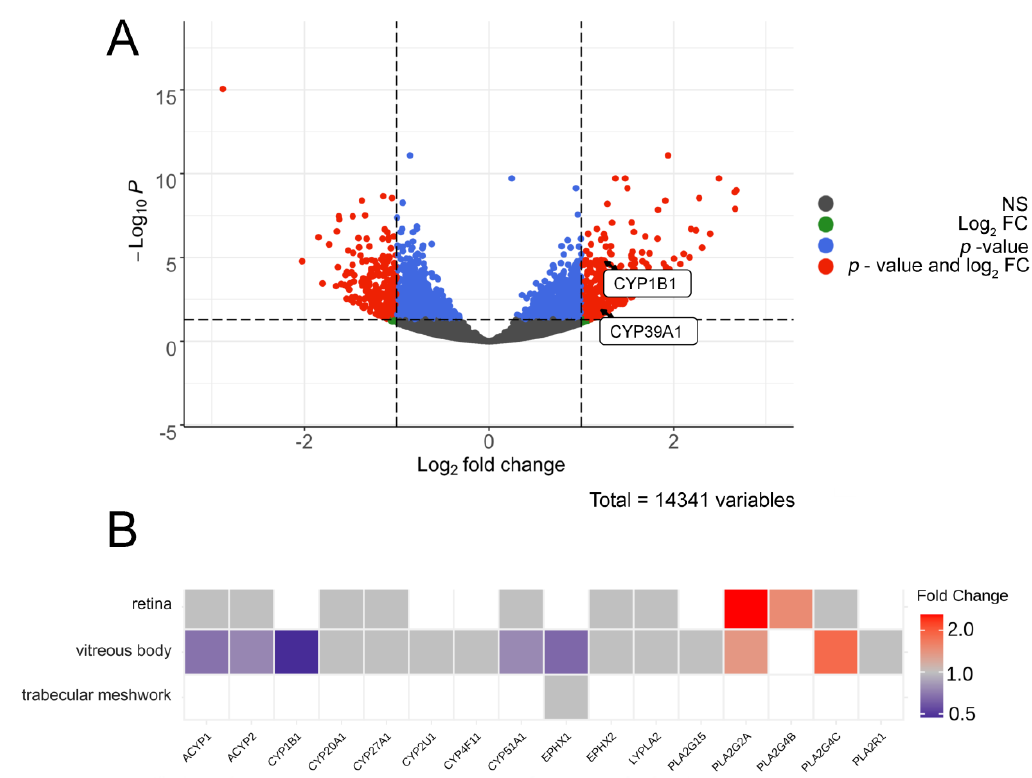
Figure 4. Bioinformatic analysis of enzymatic pathways responsible for production of the revealed POAG-specific lipid mediators in AH. ( A ) volcano plot indicating DEGs corresponding to signaling lipids-synthesizing enzymes in TM cells underwent long-term perfusion at high pressure according to analysis of the transcriptomic data 37. The X-axis indicates a log2 fold change in levels of transcripts in TM cells perfused at high pressure for 3 h as compared to 5 h. The Y-axis indicates -log10 p -values with the cut-off calculated according to Bonferroni correction. mRNAs that changed less than twofold (Log2 FC) or demonstrated non-significant (NS) alterations ( p > 0.05) are indicated in green and gray colors, respectively. The significantly changed transcripts ( p < 0.05) are denoted in red color (value and Log2 FC). ( B ) a clustered image map illustrating changes in expression of signaling lipids-synthesizing enzymes in the retina, vitreous body and trabecular meshwork of POAG patients determined from analysis of proteomic data. The map is built using the Euclidean distance and complete linkage clustering algorithm. Each entry is colored according to its fold change, rows represent tissues, and columns represent enzymes. Abbreviations: ACYP: acylphosphatase-2; CYP1B1: cytochrome P450 1B1, CYP20A1: cytochrome P450 20A1; CYP27A1: cytochrome P450 27A1; CYP2U1: cytochrome P450 2U1; CYP4F11: cytochrome P450 4F11; CYP51A1: cytochrome P450 51A1; EPHX1: epoxide hydrolase 1; EPHX2: epoxide hydrolase 2; LYPLA2: acyl-protein thioesterase 2; PLA2G15: phospholipase A2 G15; PLA2G4B: phospholipase A2 G4B; PLA2G4C: phospholipase A2 G4C; PLA2R1: phospholipase A2